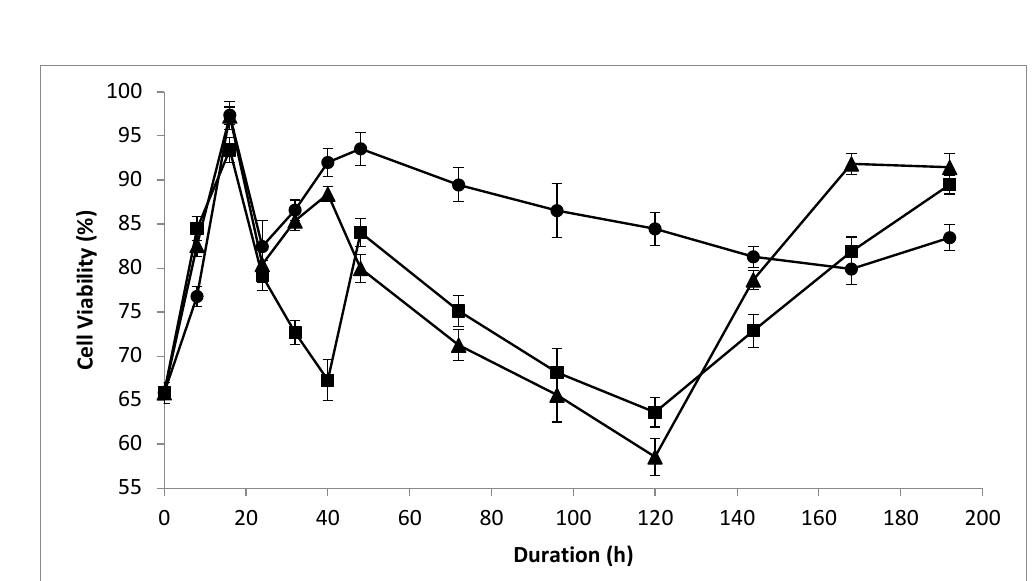
): (200 g/L glucose, (cid:35)